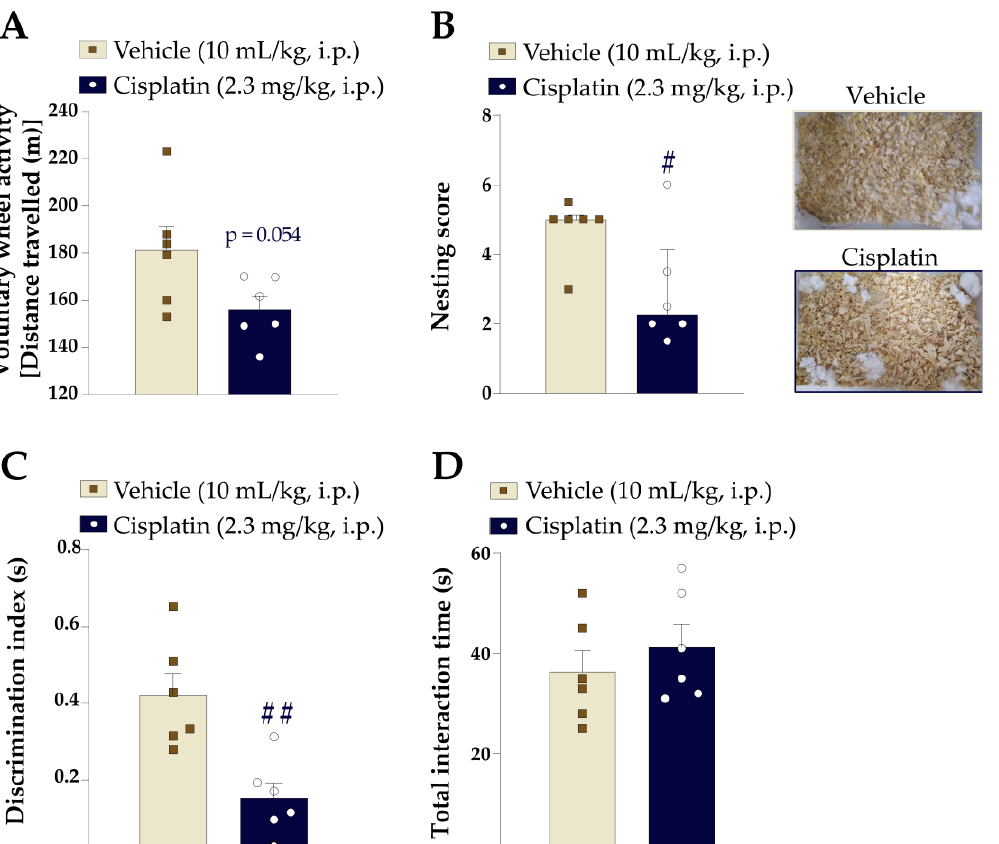
Figure 2. Treatment with cisplatin induced spontaneous nociceptive behaviours and impaired working and spatial memory in mice. Male Swiss mice were treated intraperitoneally (i.p.) with cisplatin (2.3 mg/kg) or its vehicle (10 mL/kg) from day 0 onwards every other day for a total of 10 days to induce the peripheral neuropathy experimental model. On the 11th day, the mice were subjected to behavioural tests. Spontaneous nociception was evaluated by voluntary wheel activity ( A ) and nesting behaviour ( B ). The cognitive function was evaluated by NORPT. The discrimination index demonstrates the preference for the novel object ( C ) and the total interaction time with the novel or familiar object ( D ). The symbols on the bars indicate individual values for each animal. # p < 0.05 and ## p < 0.01 vs. vehicle group. Data are expressed as the mean + SEM (n = 6/group) and were analysed by an unpaired two-tailed Student’s t -test, except ( B ) nesting score (n = 6/group) data, which are expressed as 25th and 75th percentiles (interquartile range) and were analysed by one-tailed Mann – Whitney test.